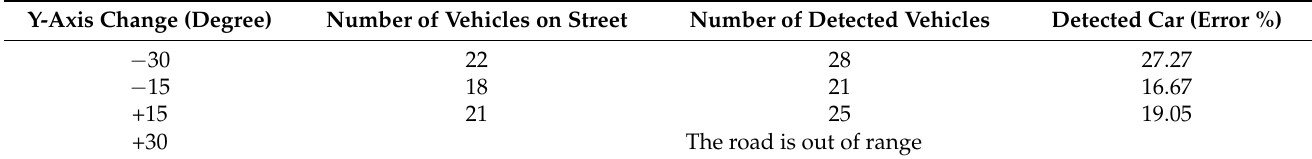
Table 9. Vehicle detection accuracy on the UAV y-axis degree variation.